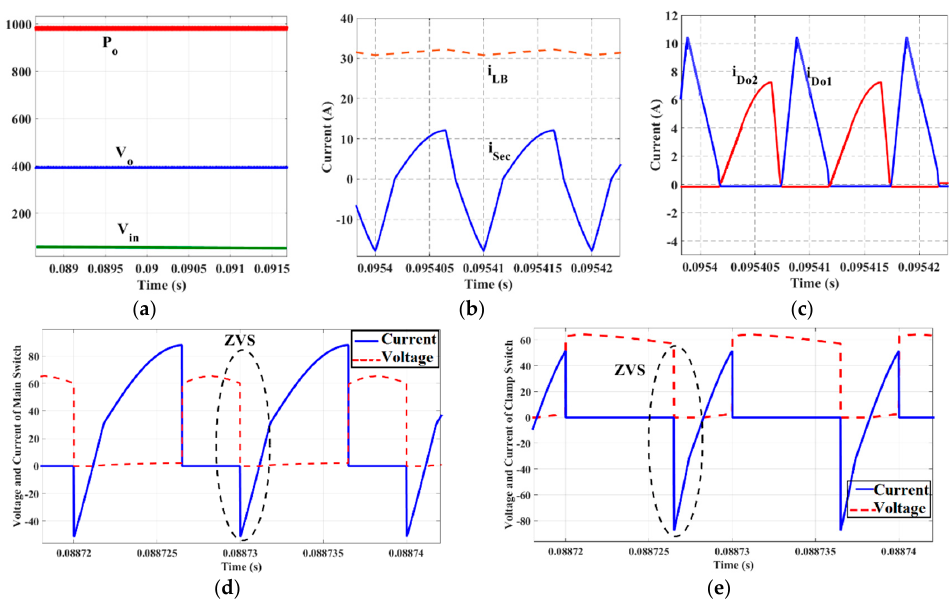
Figure 9. Simulation results. ( a ) Input voltage, output voltage, and output power; ( b ) the input current i LB and the secondary side current i Sec ; ( c ) current of the output diodes I Do1 and I DO2 ; ( d ) voltage and current of the main switch; and ( e ) voltage and current of the clamp switch.